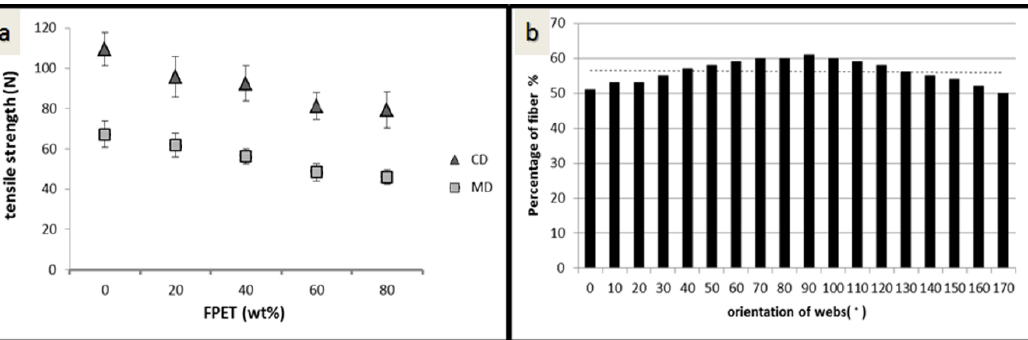
Figure 2. ( a ) Tensile strength of nonwoven fabrics in relation to FPET content; ( b ) Schematic illustration of the orientation of webs.